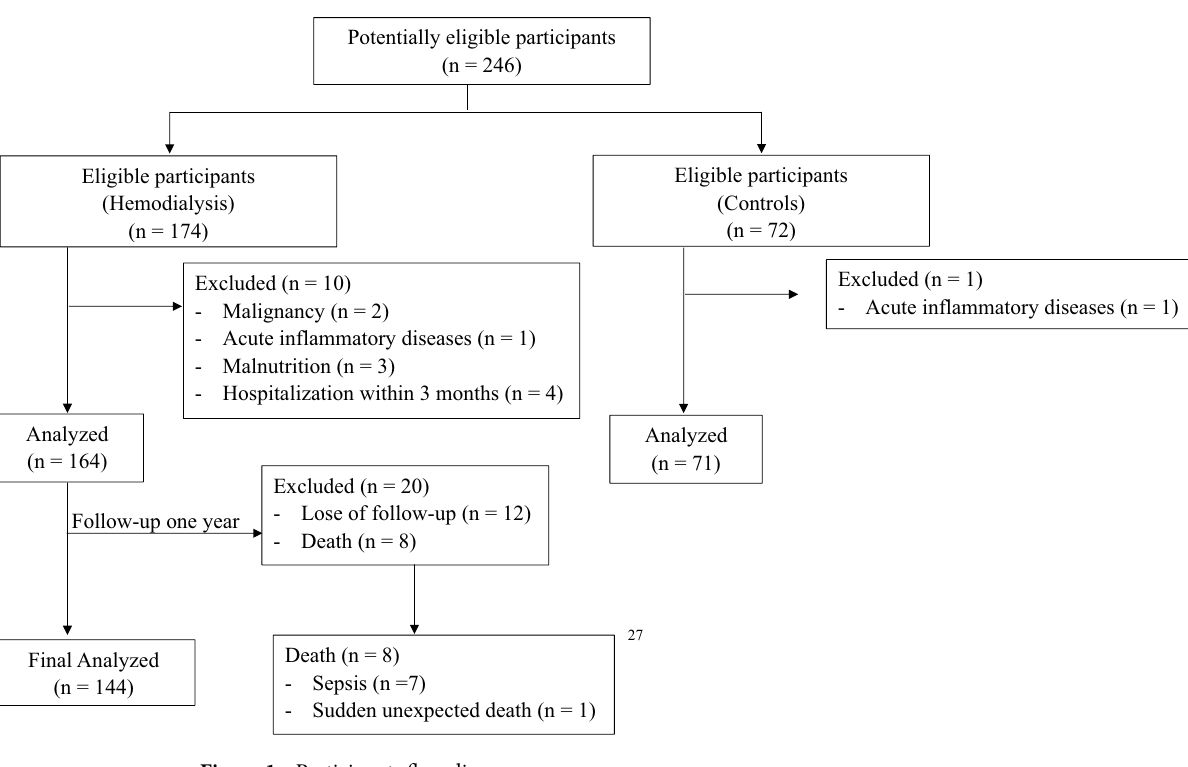
Figure 1. Participants flow